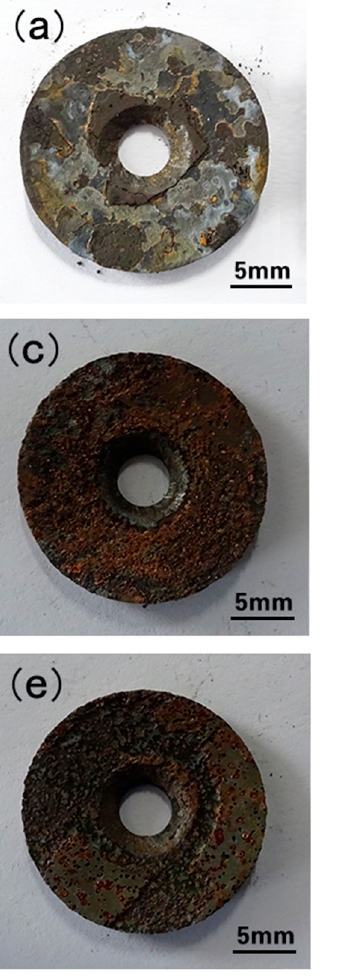
Figure 3. Macro morphologies of coupons with ( a , c , e ) and without ( b , d , f ) the corrosion film after flow loop tests at 20 °C ( a , b ), 50 °C ( c , d ), and 60 °C ( e , f ) .